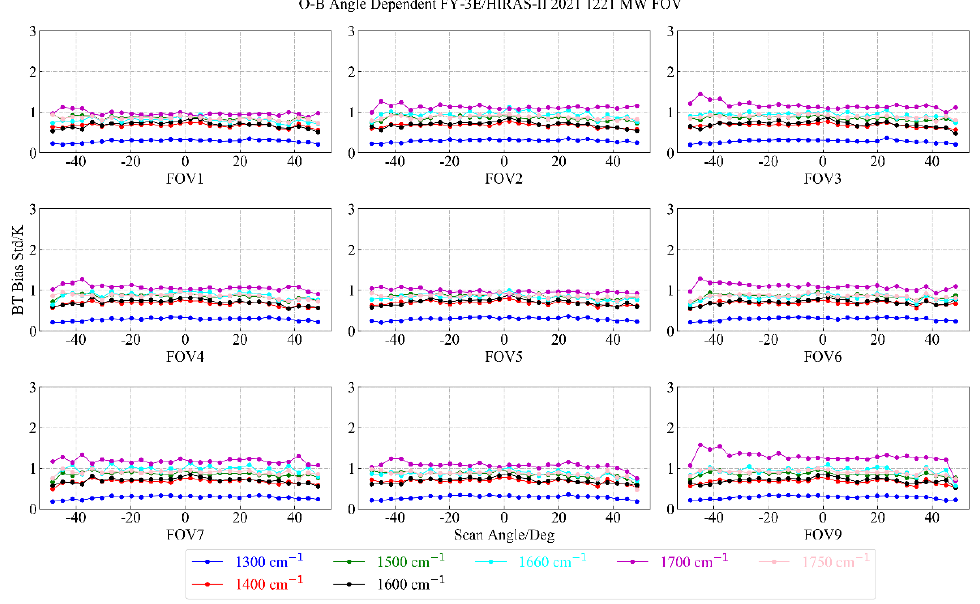
Figure 17. Distribution of OMB standard deviation of 9 FOVs of typical medium-wave channels as a function of scanning angle.